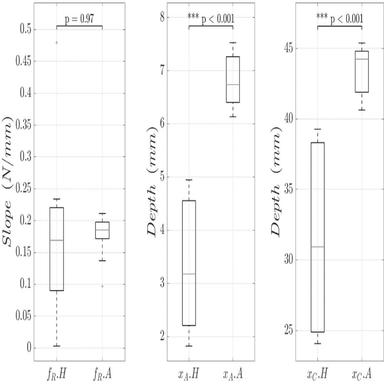
Physical model (polynomial shape function) parameters xA, xC and fR obtained from human specimens (.H) and patient phantom (.A) measurements; p-values as statistical test results above the groups, \\\ indicate a highly significant difference.